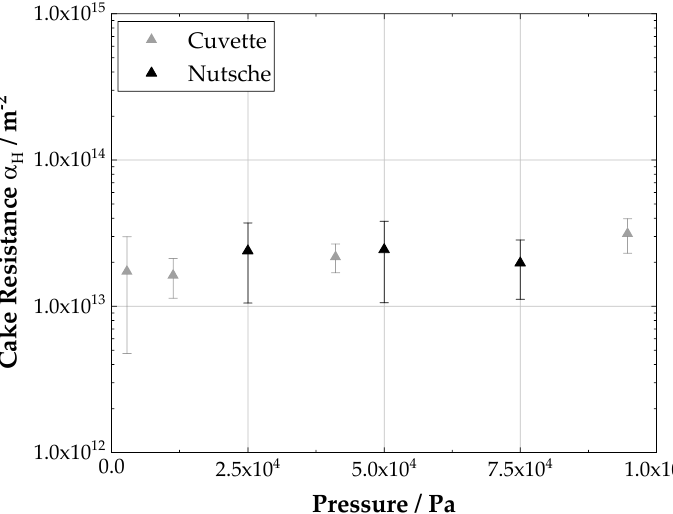
Figure 7. Height specific cake resistances from permeation experiments in the filtration cuvette [10] with crystals from Groß and Kind [6] and permeation data from the pressure nutsche with crystals produced in the process